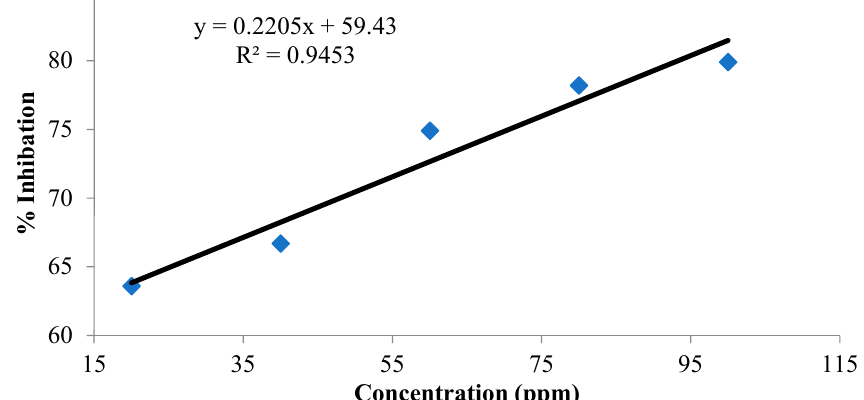
Figure 5. Graphical representation of percent inhibition versus concentration of compound 1 for radical scavenging activity.